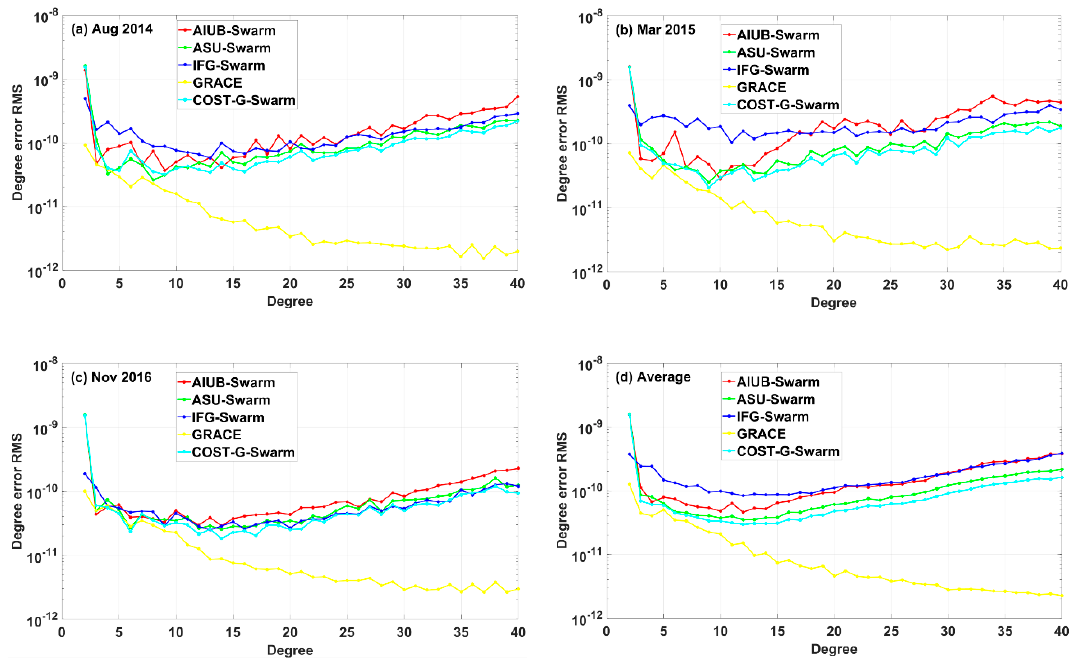
Figure 3. External coincidence accuracy of GRACE and Swarm models.